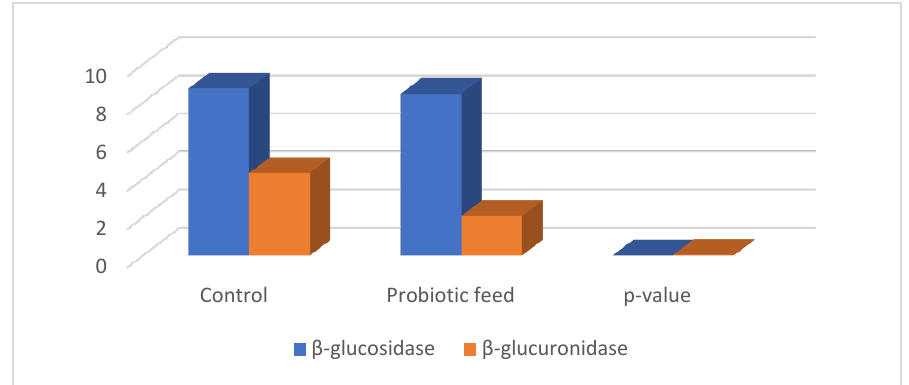
Figure 13. Cecal concentration of β - glucuronidase and β -glucosidase in control and probiotic-fed mice. The fermentation properties of Lactobacillus fermentum -NMCC-14 (accession no. MK611941)